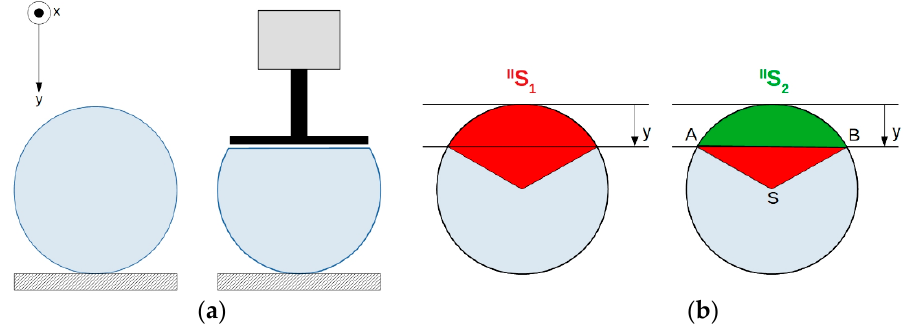
Figure 17. Deformation of AmbuBag: ( a ) Change of AmbuBag shape, ( b ) auxiliary areas.